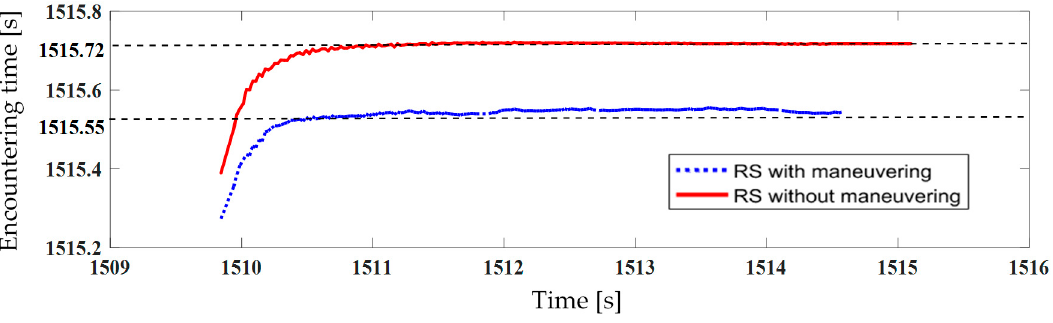
Figure 8. Prediction of encountering time with NCSO.